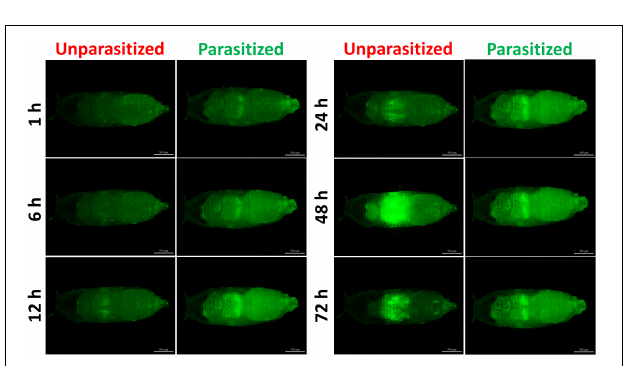
FIGURE 8 | Fluorescence microscopy of unparasitized and parasitized 10 ∗ Stat92E-GFP in Drosophila at different times. The green fluorescence was visualized through the cuticle using a florescence